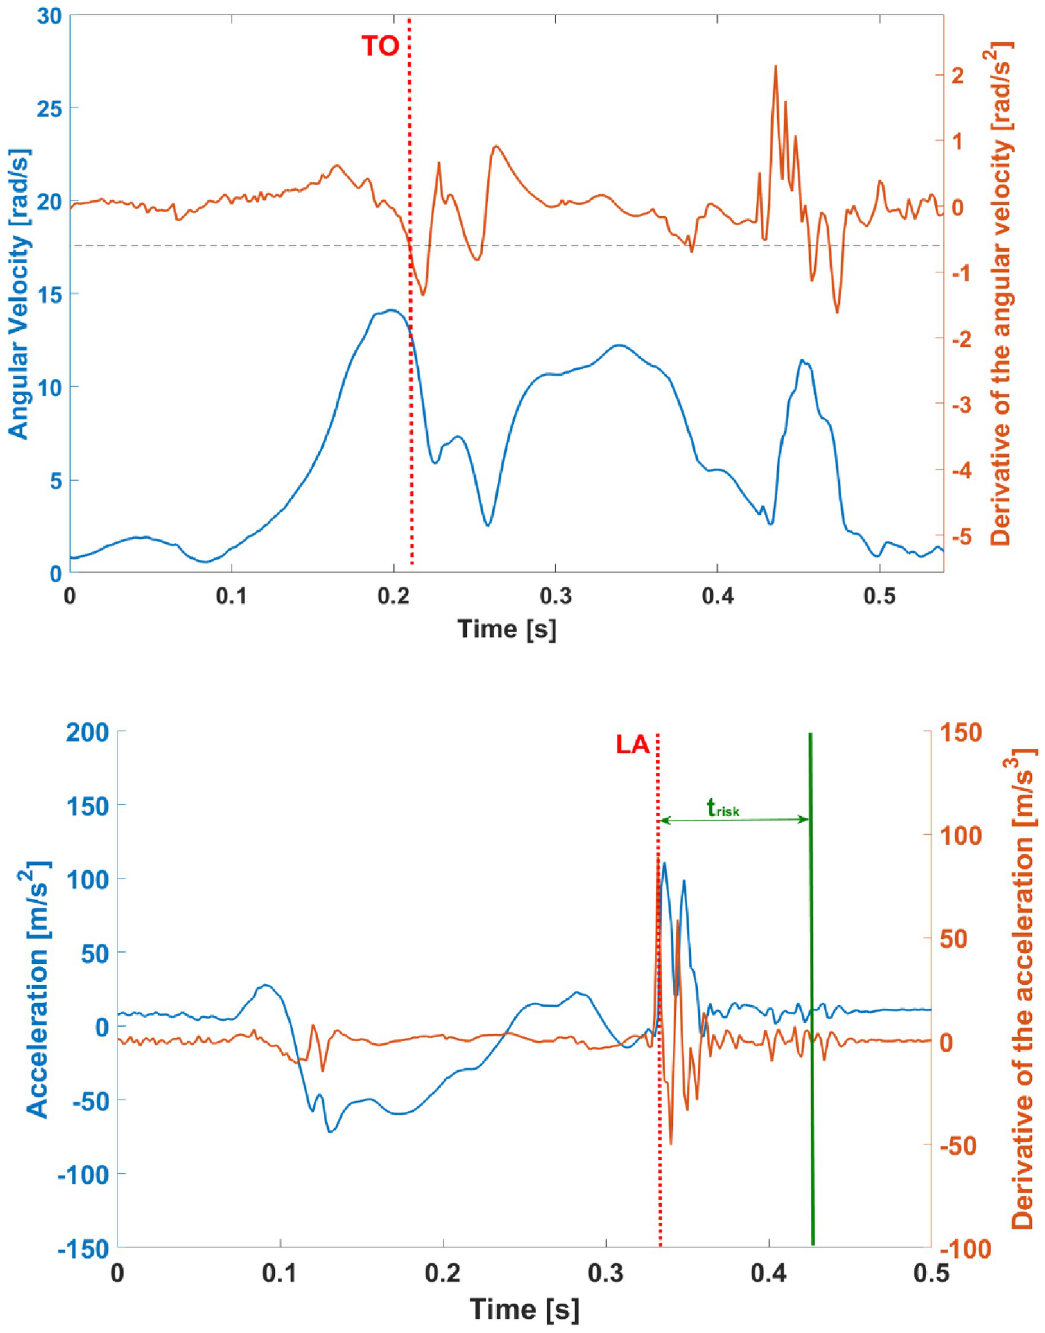
Fig 4. CHT phase segmentation: a) Top panel: Foot-based MIMU angular velocity magnitude (blue) and its derivative (orange) used to identify the take-off instant (TO, indicated with a red dashed line); b) Bottom panel: Foot-based MIMU vertical acceleration (blue) and derivative of the acceleration magnitude (orange) used to identify the landing instant (LA, indicated with a red dashed line). The 100 ms time window considered for the estimation of parameters related to the knee joint stability is also indicated (t risk indicated as a green vertical